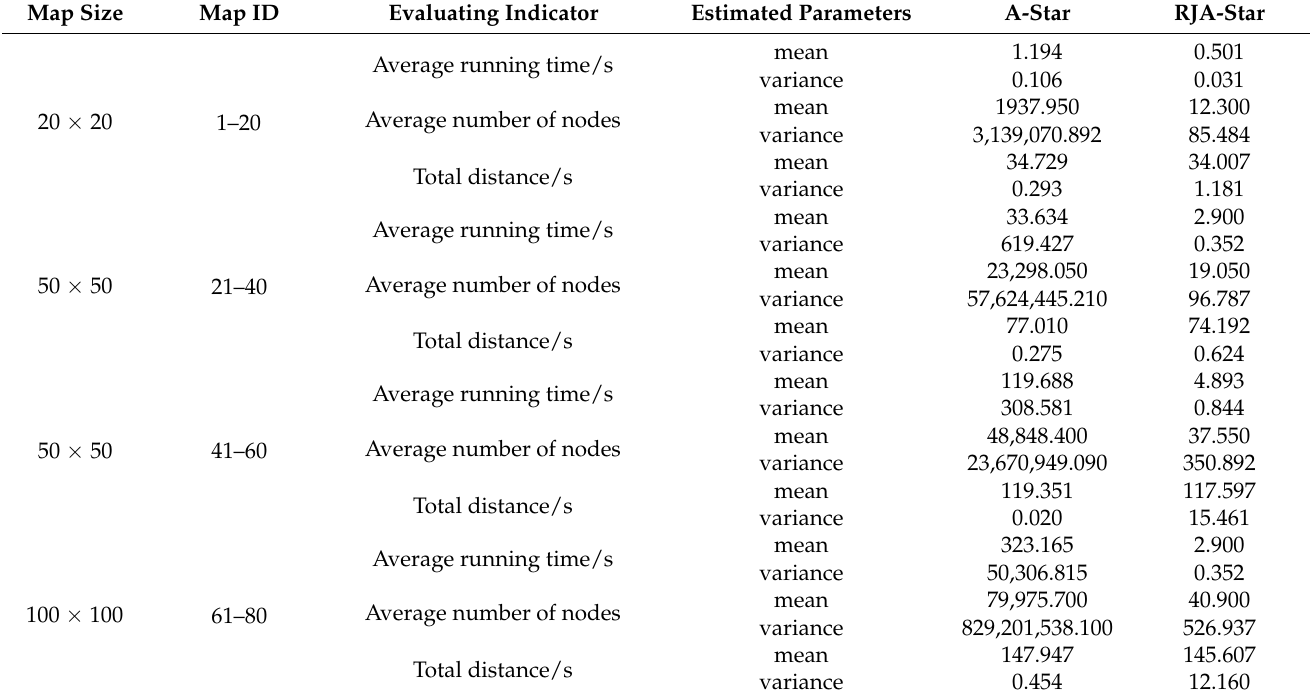
Table 3. Mean and variance of different indexes of two